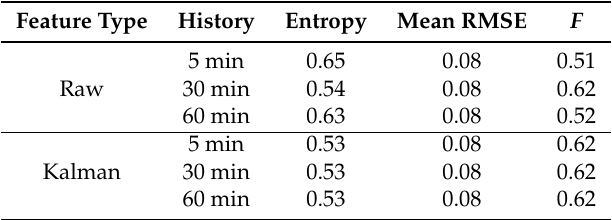
Table 4. Performance details with clustered segments and 16,000 sample